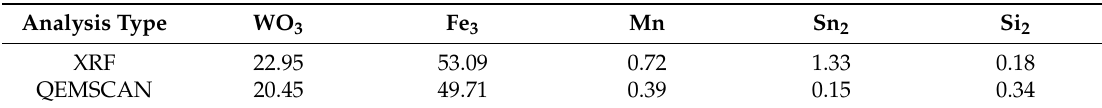
Table 3. Distribution of elements of interest in the LIMS magnetic waste material as measured by XRF and QEMSCAN.